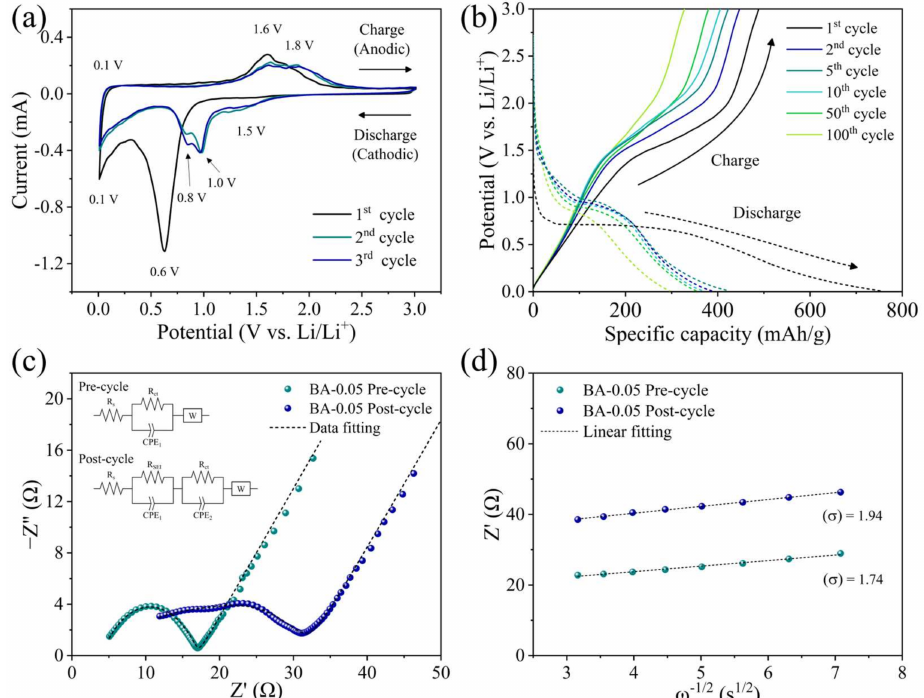
Figure 7. Electrochemical properties of prepared BA-0.05 electrode; ( a ) cyclic voltammogram at scan step 0.1 mV/s for the first three cycles, ( b ) galvanostatic charge-discharge profiles at a current rate of 0.1 A/g at different cycles between a potential range of 0.01 and 3.00 V, ( c ) EIS spectra with fitted equivalent circuit inset of before and after cycled electrode, and ( d ) line relationship of Z re and ω − 1/2